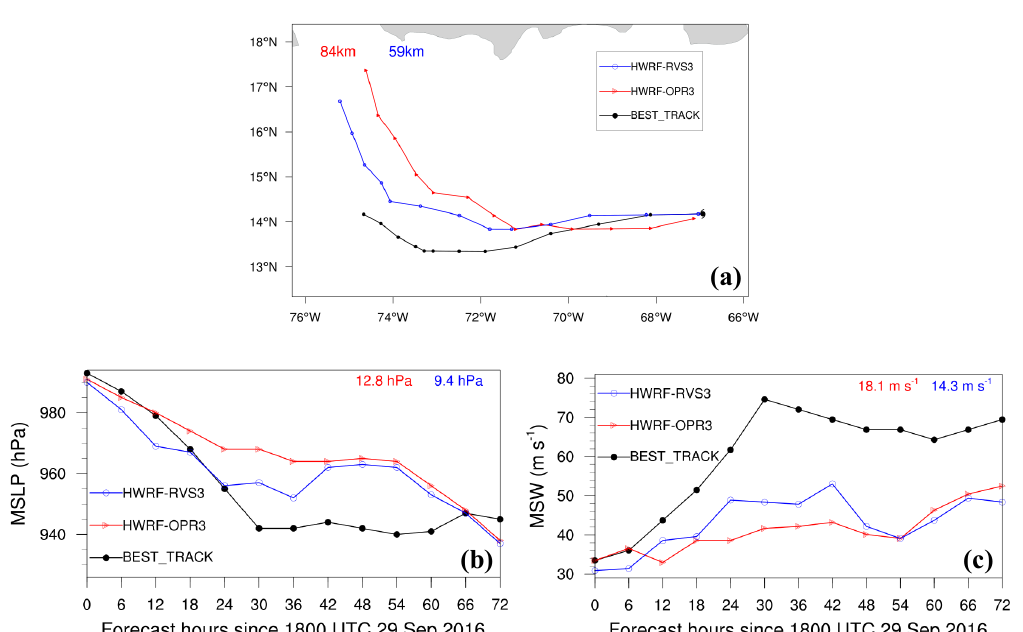
Figure 13. Time series (at 6-h intervals) of ( a ) track, ( b ) minimum sea level pressure (MSLP, hPa) and ( c ) maximum surface wind (MSW, m s − 1 ) for Hurricane Matthew during 1800 UTC 29 September–1800 UTC 02 October 2016. The colored numbers on the top of figures represent the average track ( a ), MSLP ( b ) and MSW ( c ) errors over the first 24-h forecast